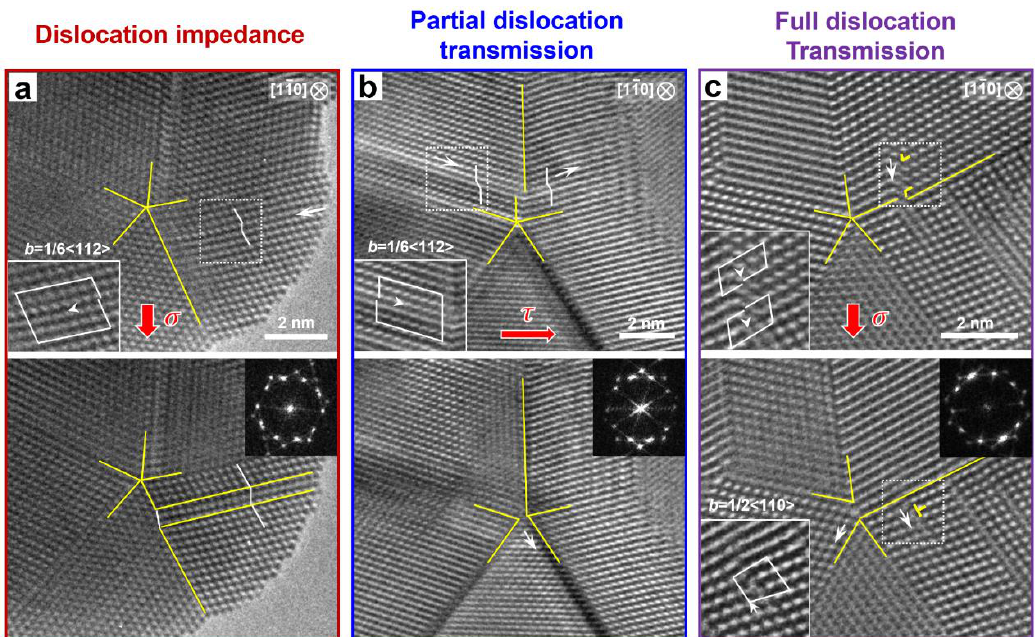
Figure 1. General reactions between dislocations and penta-twins. ( a ) Dislocation impedance in single subunit of a penta-twin. With further straining, a thin twin lamellae forms and grows along with the enlargement of a TB step. ( b ) Transmission of a partial dislocation across a TB of penta-twins. ( c ) Transmission of a dissociated full dislocation across a TB of penta-twins. The directions of dislocation propagation and mechanical loading in ( a – c ) are indicated by the white and red arrows, respectively. The insets present circuits of Burgers vectors of the propagating dislocations and the corresponding fast Fourier transform (FFT) patterns of penta-twinned nanocrystals.